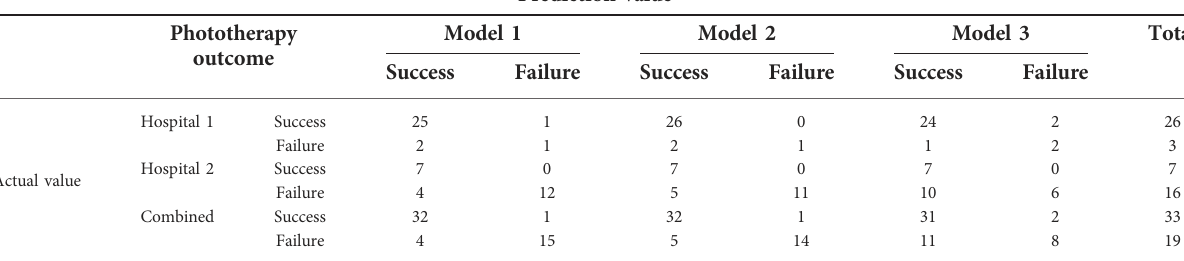
TABLE 9 Validation cohorts and prediction results based on different cutoffs, by hospital and